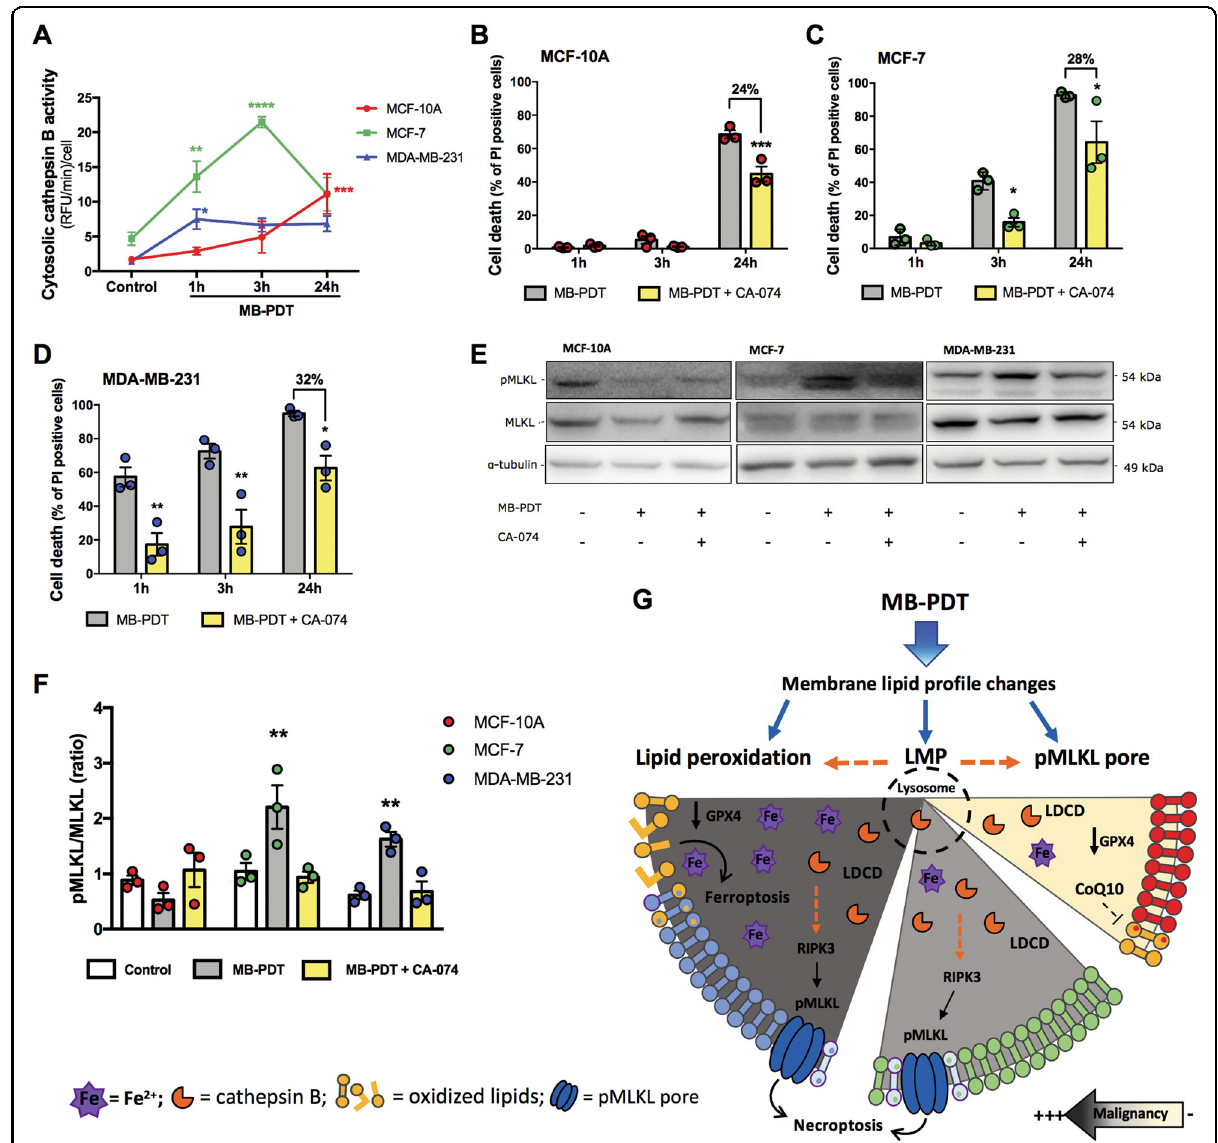
Fig. 5 MB-PDT-induced LMP is involved on cell death of breast cells. A Cells were submitted or not to MB-PDT and cytosolic cathepsin B activity was analyzed after 1, 3, or 24 h of cell treatment. **** p < 0.0001, *** p < 0.001, ** p < 0.005, * p < 0.05 vs. Control. B MCF-10A, C MCF-7, and D MDA-MB- 231 cells were pretreated or not with CA-074 and then submitted or not to MB-PDT. Cell death was analyzed after 1, 3, 24 h of cell irradiation: *** p < 0.001, ** p < 0.005, * p < 0.05 vs. MB-PDT. E Representative images of western blottings of pMLKL, MLKL, and tubulin of BC treated or not with CA-074 and MB-PDT after 24 h, as indicated. F pMLKL/MLKL ratio of cells after 24 h they were treated or not with CA-074 and then submitted to MB-PDT. ** p < 0.005 vs. Control. Dot colors representation: MCF-10A in red, MCF-7 in green, and MDA-MB-231 in blue. n ≥ 3 independent experiments. Graph results are presented as mean ± SEM. G Cell death mechanisms activated by MB-PDT in BC ranging from non-malignant to very aggressive tumorigenic cells (from right to left). Upper part shows that photo-oxidation induces membrane lipid pro fi le changes such as lipid peroxidation, LMP, and/or pMLKL pore formation. Bottom part of the fi gure represents the differential lipid composition of each BC analyzed (represented by different lipid membrane colors) and which mechanisms are activated in each one (LDCD: lysosome-dependent cell death, necroptosis, or ferroptosis). MDA- MB-231 cells: dark gray background, with higher proportion of lipids to undergo lipid peroxidation, MCF-7: gray background displaying lipids not susceptible to peroxidation, MCF-10A: yellow background and bearing intermediate abundance of lipids being susceptible to